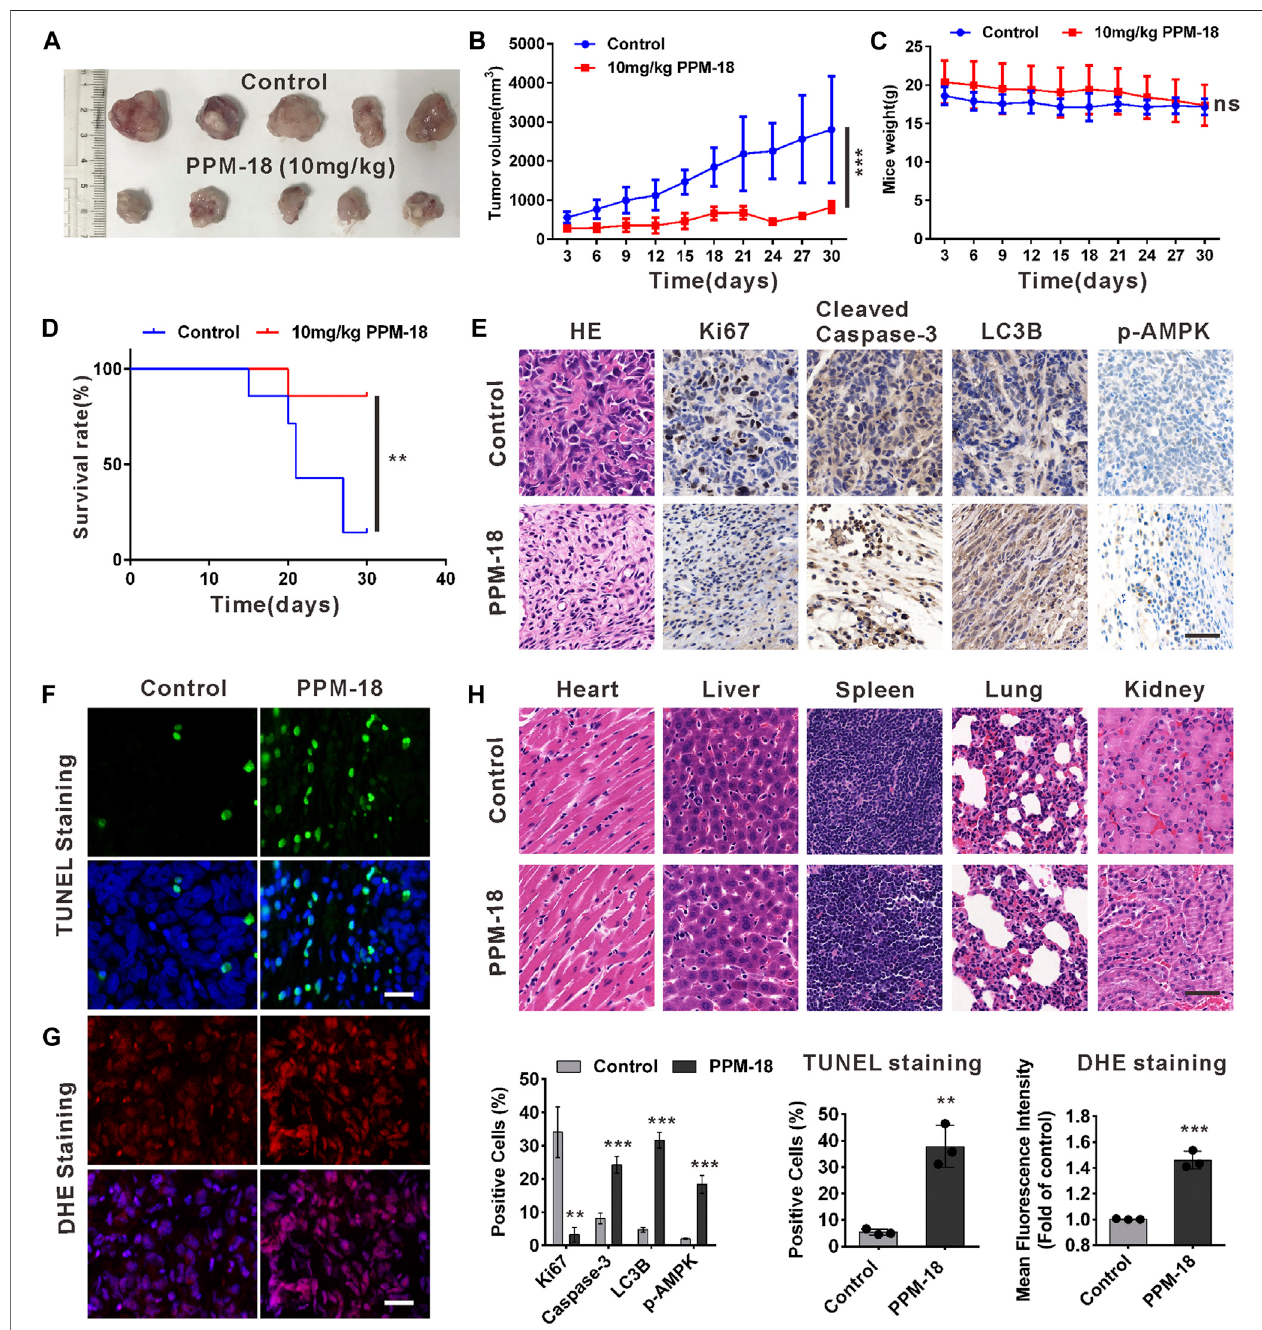
FIGURE 7 | PPM-18 inhibits the growth of bladder cancer xenografts in nude mice. (A) and (B) Tumor volume changed during administration with or without 10 mg/kg PPM-18 every day for 30 days. (C) Mice weight altered during administration with or without PPM-18 for 30 days. (D) Survival curves in the two groups of mice. (E) The autophagy and apoptosis in bladder tumor tissues from PPM-18 – treated group and the control group. HE staining and the expression levels of Ki67, cleaved caspase-3, LC3B, and p-AMPK were examined by immunohistochemistry, scale bar: 50 μ m. (F) and (G) TUNEL staining for apoptosis assay and DHE staining for ROS detecting were analyzed by fl uorescence microscope, scale bar: 50 μ m. (H) The cytotoxic effect of treatment with or without PPM-18 on several important organs from nude mice. HE staining was used to assess the histology, scale bar: 50 μ m. Data are presented as the mean ± SD of at least three independent experiments. ** p < 0.01 and *** p < 0.001 vs. the control group. ns: no signi fi cance.